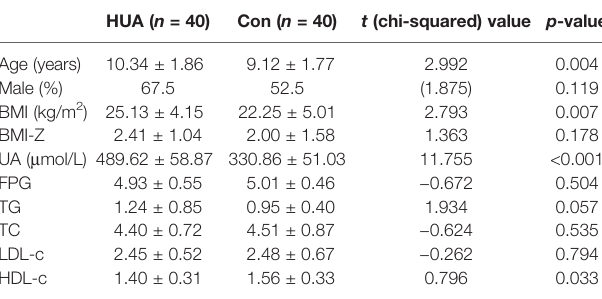
TABLE 1 | Anthropometric pro fi les and laboratory